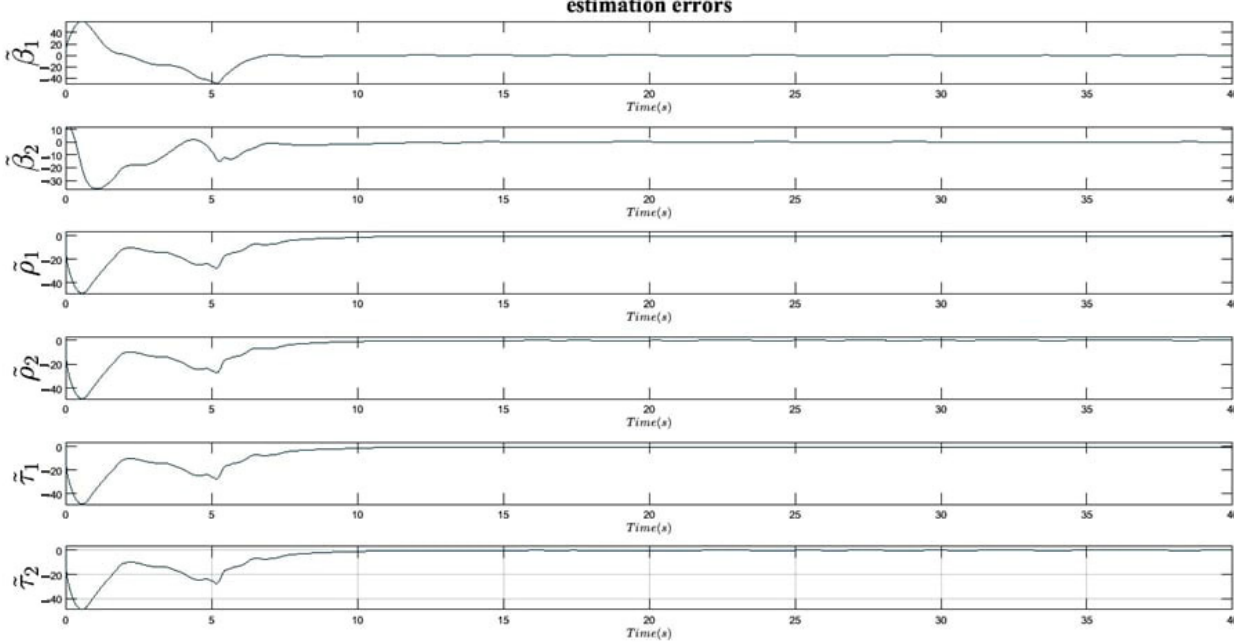
Figure 7. Uncertainty and disturbances of the master and slave systems. In this article, simulations have been performed for 𝑡 (cid:3404) 40 S , where 𝑘 (cid:2869)(cid:2869) (cid:3404) 𝑘 (cid:2870)(cid:2870) (cid:3404) 10 and 𝑘 (cid:2869)(cid:2870) (cid:3404) 𝑘 (cid:2870)(cid:2869) (cid:3404) 20 have been selected. Additionally, the gain and time constants of the non ‐ linear fractional order PID sliding surface are 𝑘 (cid:3043) (cid:3404) 1.5 , 𝑇 (cid:3036) (cid:3404) 0.75 and 𝑇 (cid:3031) (cid:3404) 0.5 . The fractional order of the integral and derivative part of the sliding surface is defined as 𝛿 (cid:3404) 0.4 and 𝜆 (cid:3404) 0.75 . The parameters of the proposed robust controller are 𝑏 (cid:3404) 2 . The uncer ‐ tain time delays of the system are 𝜏 (cid:2869) (cid:3404) 0.65 and 𝜏 (cid:2870) (cid:3404) 0.35 . Unknown disturbances ap ‐ plied to both systems are as follows: 𝑑 (cid:2869) (cid:4666)𝑡(cid:4667) (cid:3404) 𝑠𝑖𝑛 (cid:2870) 3 𝑡 (cid:3397) 2 𝑐𝑜𝑠 4 𝑡 ,